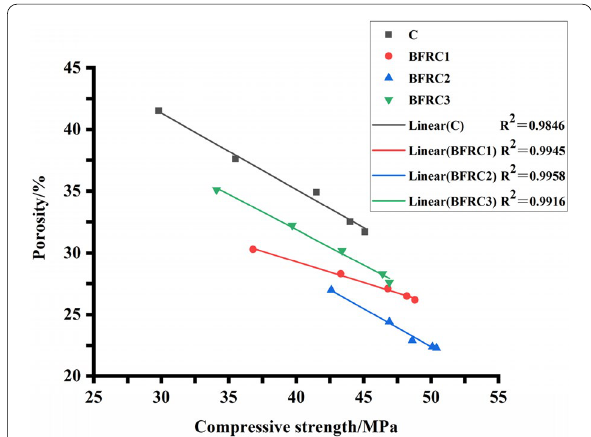
Fig. 19 Relationship between pore size distribution and compressive strength (C).